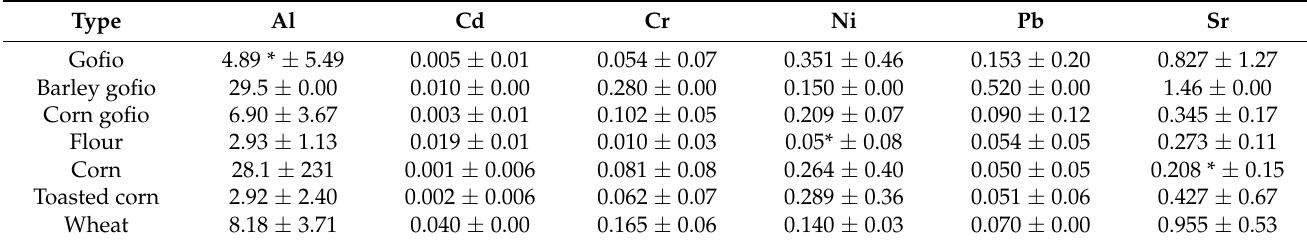
Table 5. Mean concentrations and standard deviations (mg/kg fresh weight ± SD) of the analyzed toxic metals by cereal and cereal derivative